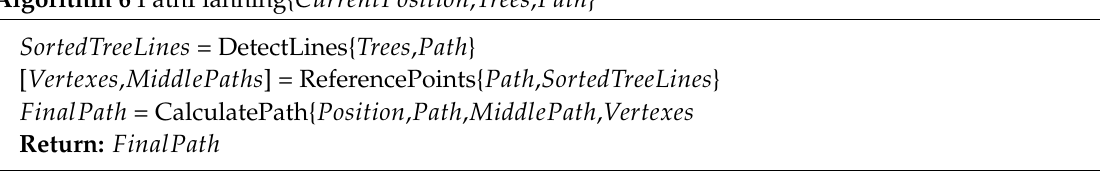
Algorithm 6 PathPlanning{ CurrentPosition , Trees , Path }